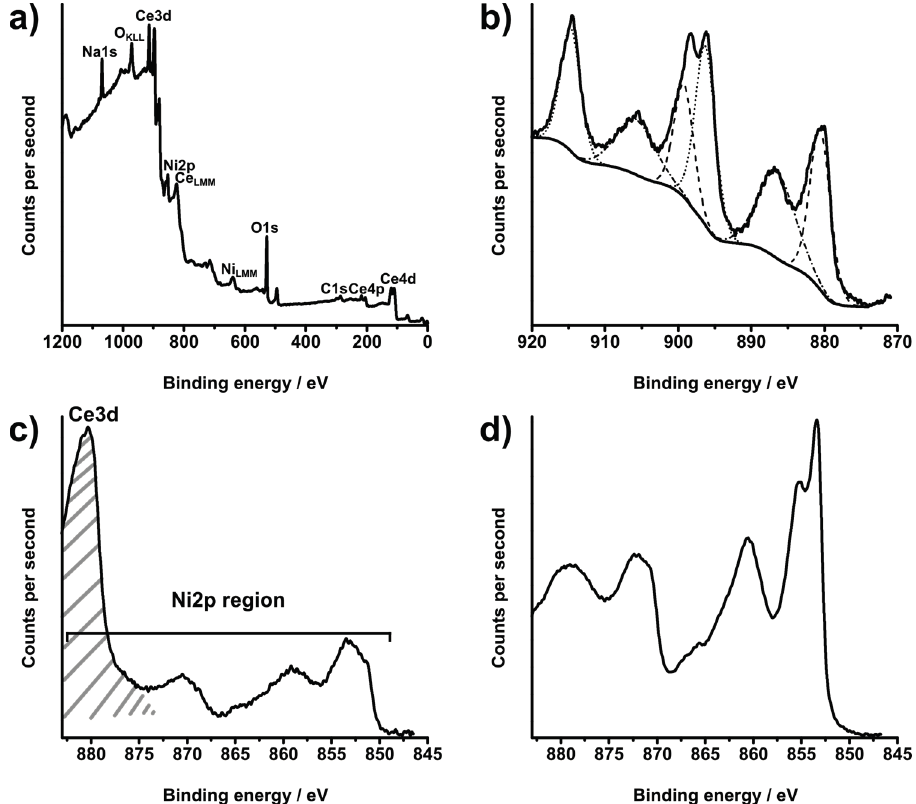
Figure 3. ( a ) XPS survey scan of Sample 3 (50% Ni-CeO 2 ) showing elements present; ( b ) Fitted Ce 3d high resolution XPS spectrum showing the 3 doublets that are indicative of Ce(IV) and indeed CeO 2 ; ( c ) Ni 2p region of Sample 3, showing the overlapping Ce 3d region which masks the Ni 2p 1/2 region; ( d ) is a high resolution scan of the Ni 2p region in